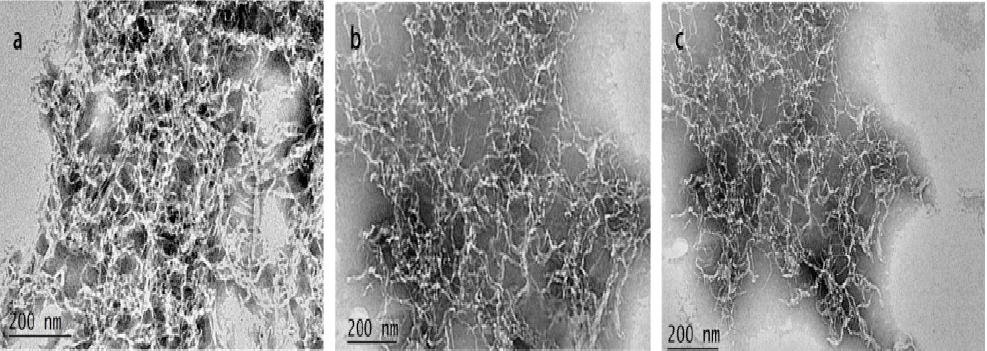
Figure 4. TEM images: ( a ) ACNC-20 °C, ( b ) ACNC-30 °C, ( c ) ACNC-40 °C.